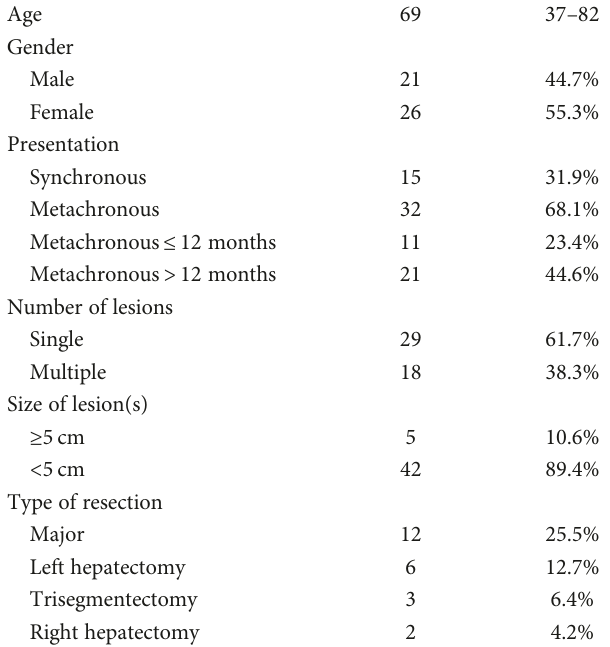
Table 1: Baseline patient features, tumor characteristics, and surgical details.